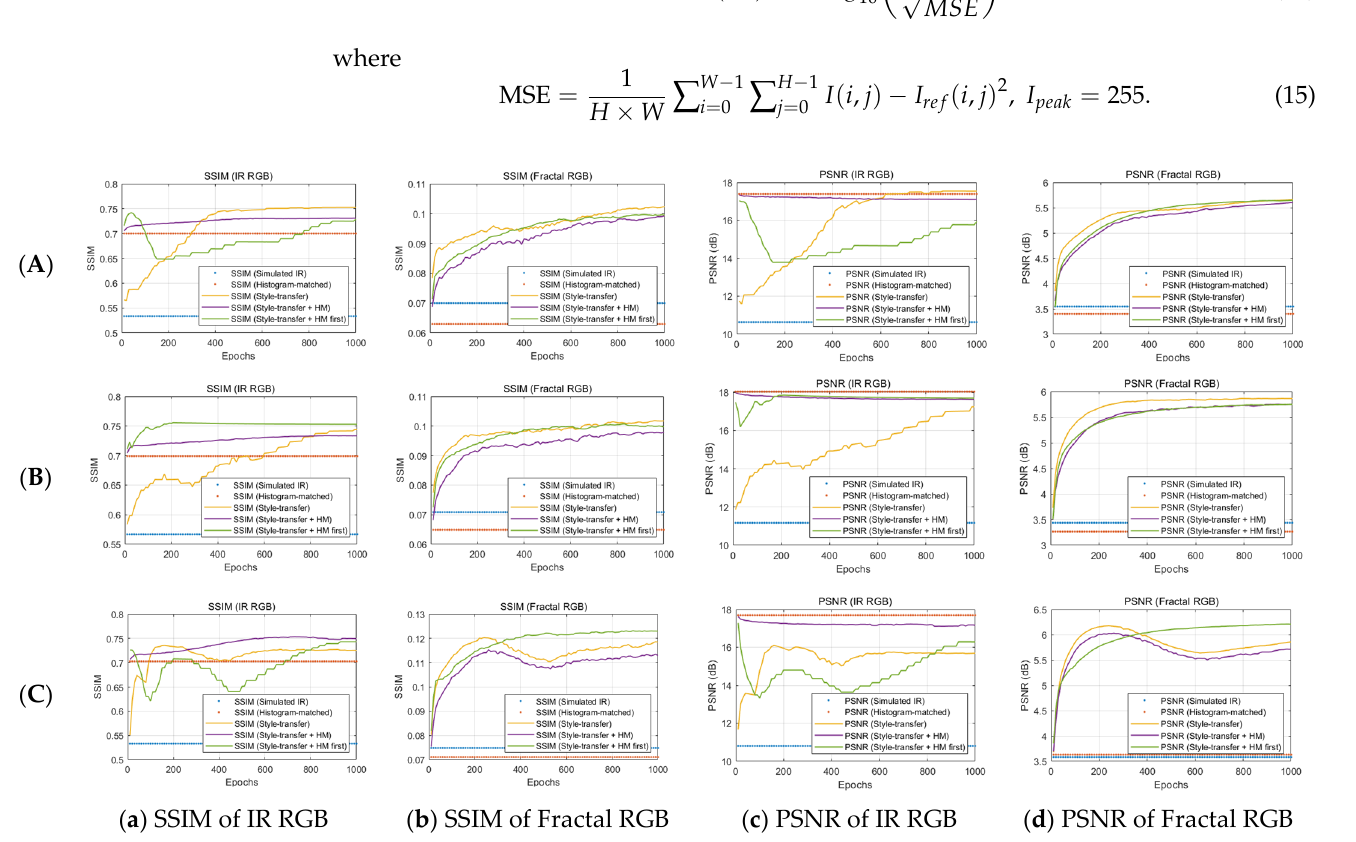
Figure 5. Results of SSIM and PSNR of false-colored IR RGB image and fractal RGB image in each of the three simulation conditions: ( A ) Cloudy summer weather at 20 h; ( B ) Fine summer weather at 20 h; ( C ) Cloudy summer weather at 10 h with the four different image generation techniques mentioned in Figure 4.